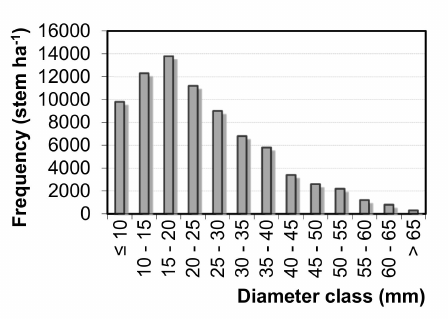
Figure 4. A histogram of diameter classes of rhododendron basal diameters on PRP.